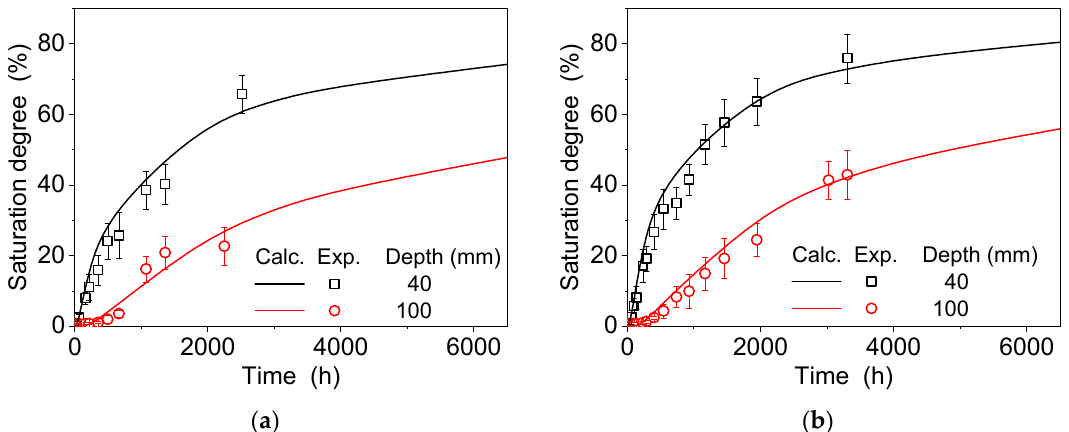
Figure 4. Local saturation degrees of solute at different times and locations (in the dissolution and diffusion processes of single electrolyte in water): ( a ) MgSO 4 ; ( b ) Na 2 SO 4 .